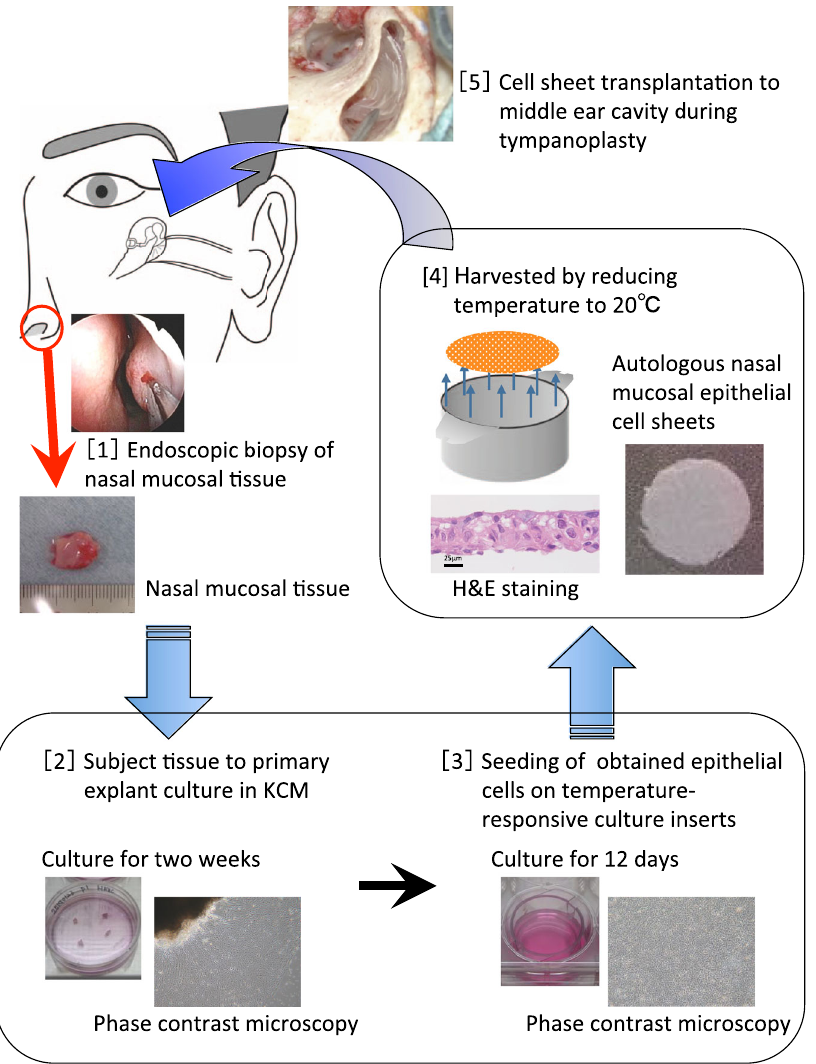
Fig. 1 Transplantation of autologous tissue-engineered epithelial cell sheets fabricated from nasal mucosa. [1] In fi ltration anesthesia of the inferior nasal turbinate mucosa was performed via nasal endoscopy by application of xylocaine. A ca . 10 × 10 mm section was harvested from the inferior nasal turbinate mucosa. [2] The harvested epithelia were minced as fi nely as possible, placed in a culture dish coated with type I collagen and subjected to primary explant culture in KCM for 2 weeks. Cells started to grow and move outside from the explant of